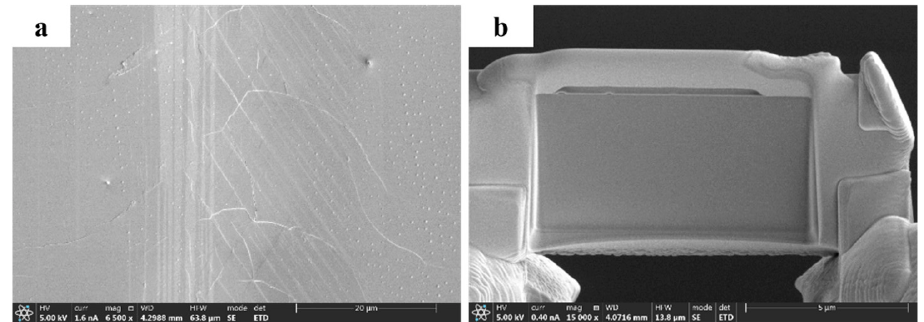
Figure 15. Sample at low magnification ( a ) part-graph and ( b ) panoramic drawings of samples.